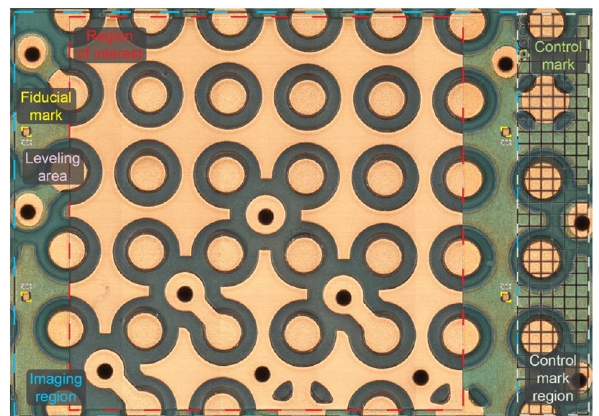
Figure 3. The different regions, marks, and areas on the sample for the whole process.